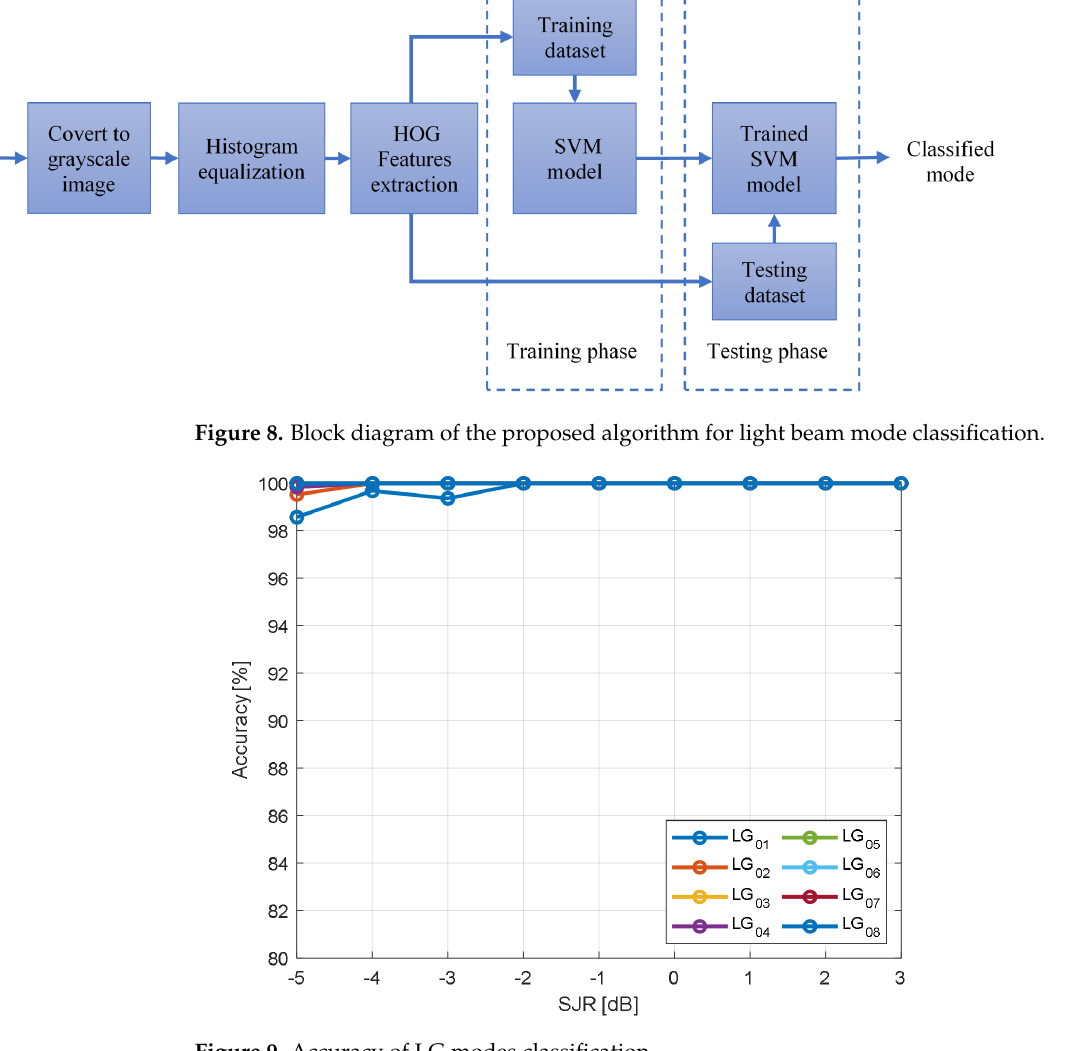
Figure 9. Accuracy of LG modes classification.